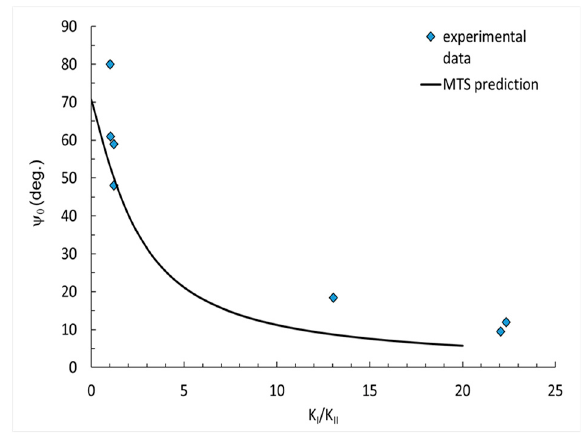
Figure 8. Crack initiation angles for 50phr Al(OH) 3.